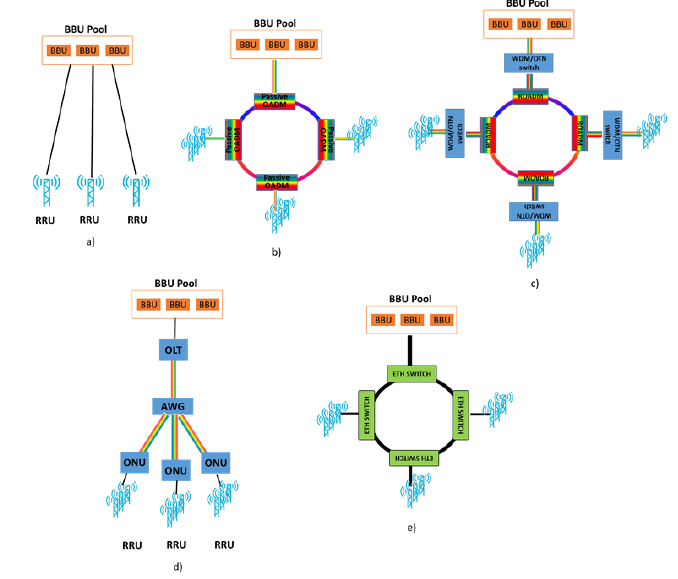
Figure 1. Optional fronthaul network technologies in the C-RAN architecture: dark fiber ( a ); Passive WDM ( b ); WDM/OTN ( c ); WDM/PON ( d ); and Ethernet ( e ).